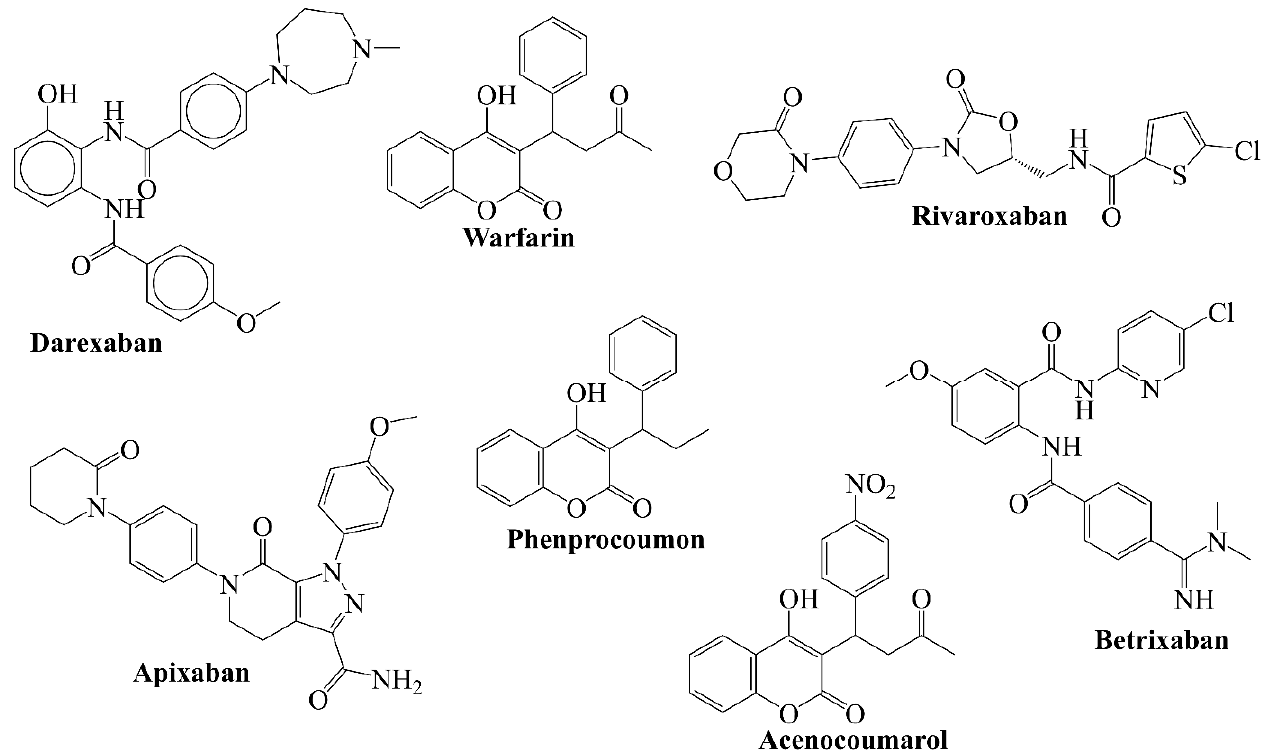
Figure 2. Some marketed anti-coagulating drugs.